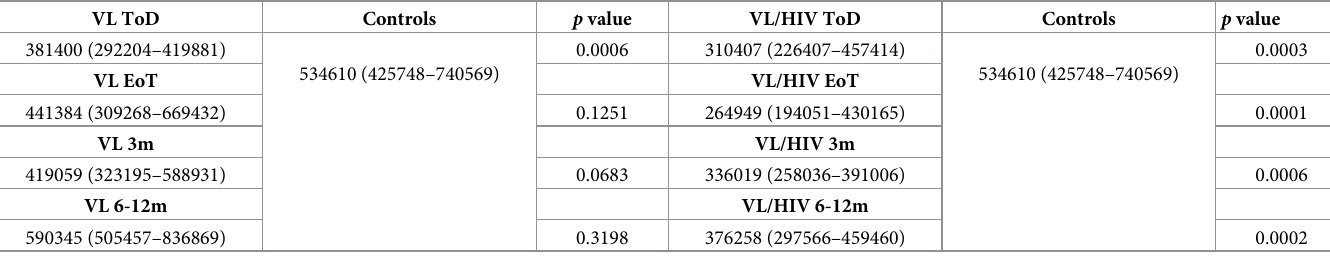
Neutrophils were isolated by dextran sedimentation from the blood of controls (n = 15), VL (ToD: n = 14, EoT: n = 14, 3m: n = 13, 6-12m: n = 27) and VL/HIV (ToD: n = 16, EoT: n = 24, 3m: n = 15, 6-12m: n = 26) patient and the MFI of E . coli particles were measured by flow cytometry as described in Materials and Methods. Each symbol represents the value for one individual, the straight lines represent the median. Statistical differences between VL patients at each time point during follow-up and controls; and between VL/HIV patients and controls at each time point during follow-up and controls were determined using a Mann-Whitney test. Results are presented as median with interquartile